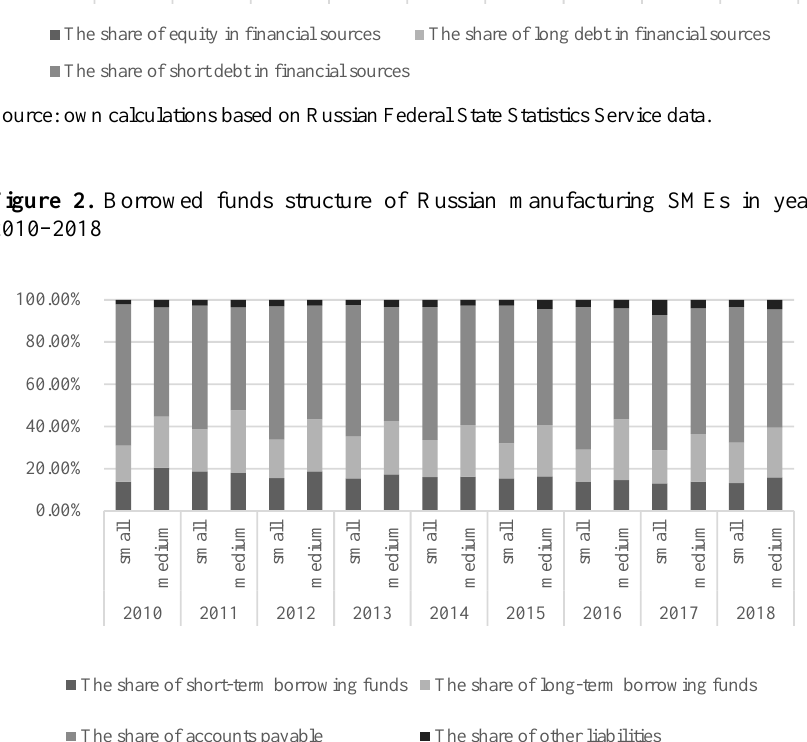
Source: own calculations based on Russian Federal State Statistics Service